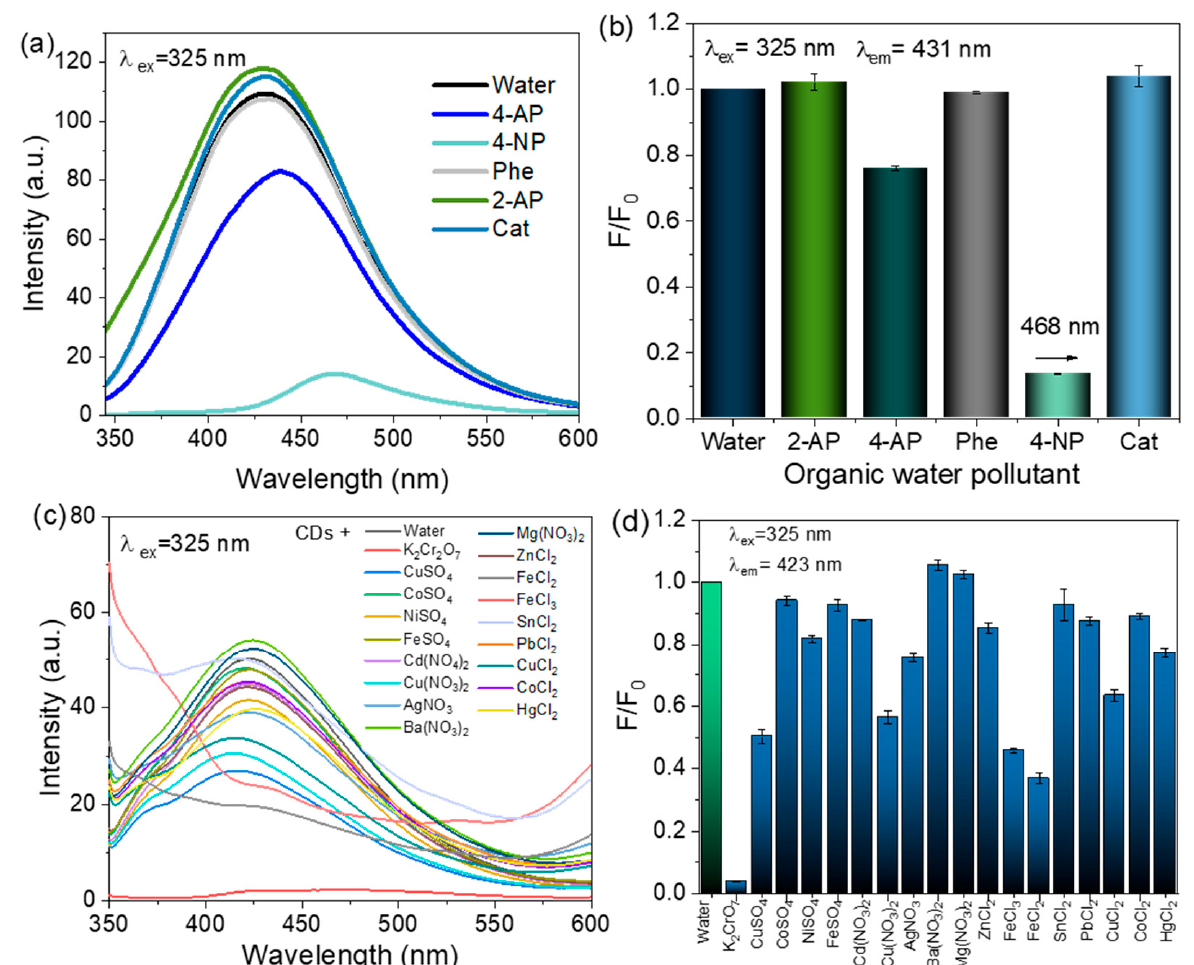
Figure 2. Selectivity studies of CDs towards different organic pollutants in deionized water: ( a ) PL emission spectra taken at a 1 mM concentration of the analyte, (volumetric ratio of analytes,: CDs: total volume 1:120) and ( b ) relative/normalized PL peak emission intensity (F/F 0 ) (with respect to the control) for each analyte, where F0 is the control, i.e., PL is the peak intensity of only CDs; and ( c ) PL response towards different metal ions taken at 10 mM of metal ion concentration and ( d ) relative/normalized PL peak emission intensity (F/F 0 ) (with respect to the control) for each metal ion.